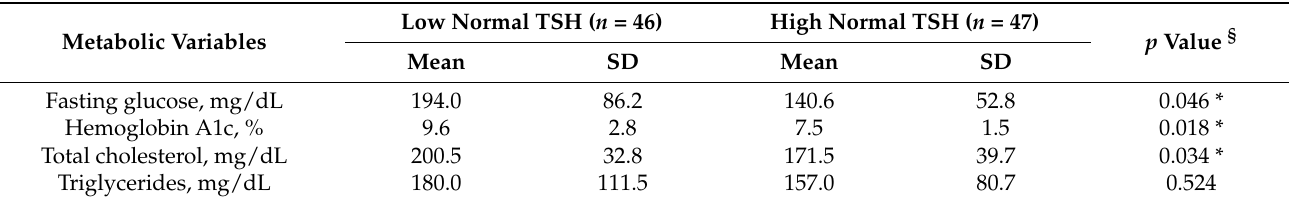
Table 4. Cardiometabolic Risk Factors by TSH Group ( n = 93)